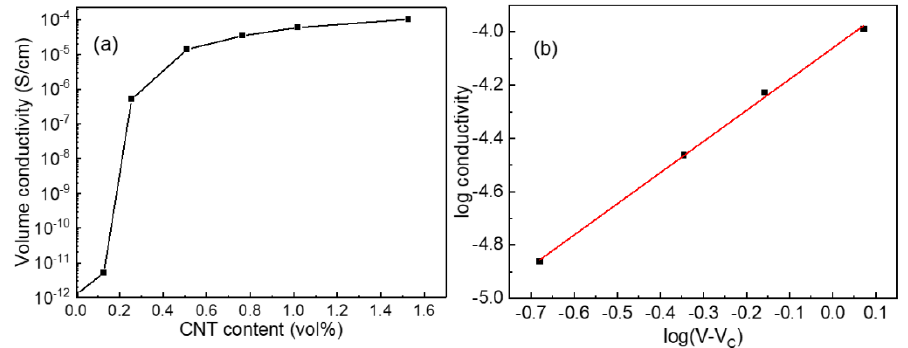
Figure 6. ( a ) Volume conductivity plotted as a function of CNT content; ( b ) log( σ ) plotted as a function of log(V-Vc).